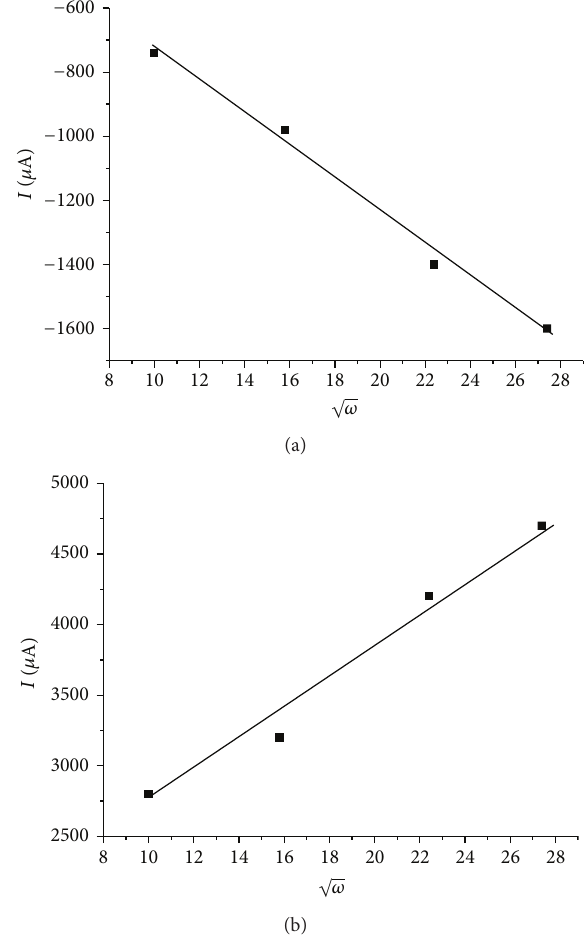
Figure 5: The dependence of the current density of the cathode (a) and anode (b) peaks on √𝜔 , where 𝜔 is angular frequency of the stirrer. Conditions as given in Figure 4.